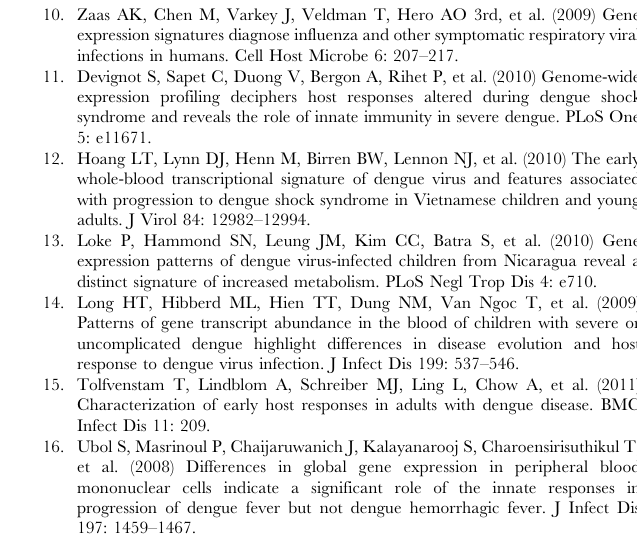
Figure S1 Distribution of PBMC RNA samples by day of fever. DF1= dengue fever, primary DENV infection; DF2= den- gue fever, secondary DENV infection; DHF = dengue hemor- rhagic fever; DSS= dengue shock syndrome. Figure S2 First principal component in the full gene expression data set for dengue patients on fever day 4 and healthy controls. Principal components were derived from the dataset of 10,075 probes used for all analyses, including the data presented in Figure 1. Figure S3 First principal component in the data. (A) Fever day 3. (B) Fever day 5. H= healthy control; DF1= dengue fever, primary DENV infection; DF2= dengue fever, secondary DENV infection; DHF= dengue hemorrhagic fever; DSS = den- gue shock syndrome. Figure S4 Rank correlation of transcript abundance and platelet levels in dengue patients. Median transcript abundance for each patient group on each of days 3 through day 7 (5 columns per group) is presented. Red indicates more abundant than controls; green indicates less abundant. Gray columns separate each group; the black column represents median value for healthy controls. Vertical lines and numbers 1–4 correspond to gene clusters identified in Fig. 2 discussed in the text. A moving